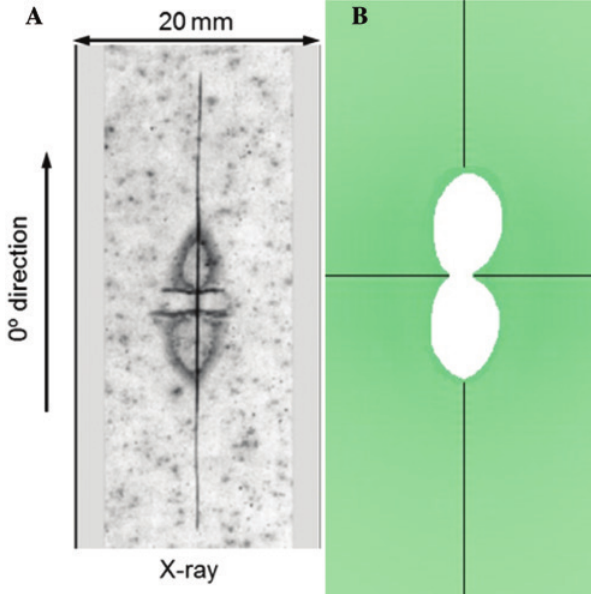
Figure 11: The time curve of the impact contact force of the laminate plate for experiment and simulation. (A) The layered damage for experiment in Ref. [13]. (B) The damage of adhesive layer for